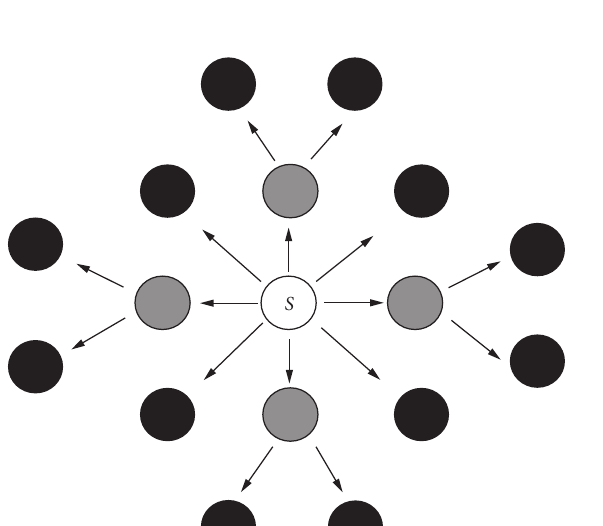
Figure 1: VANET communication architecture.